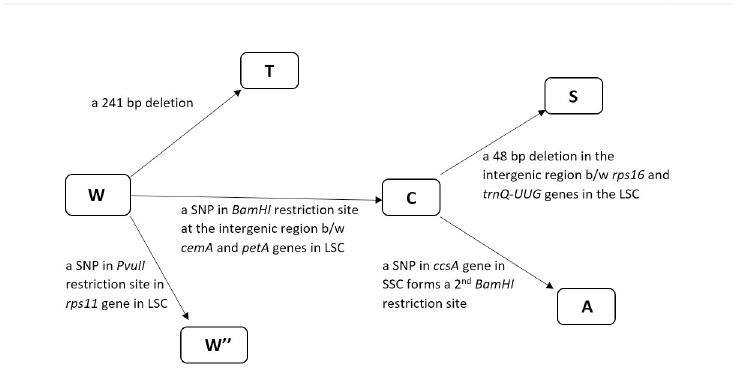
Fig 7. Schematic representation of evolution of cpDNA types in potato. The W-type is the primitive type of potato plastome from which other types were derived. A 241 bp deletion in the W-type gave rise to the T-type cpDNA [11]. The W2 (W”) is derived from W due to a single nucleotide change. Similarly, the C-type is derived from the W-type by a single nucleotide change which further formed the S- and A-type plastomes. The A-type derived from the C-type due to the formation of a second restriction site by an SNP, while a 48 bp deletion in the C-type led to the S-type.